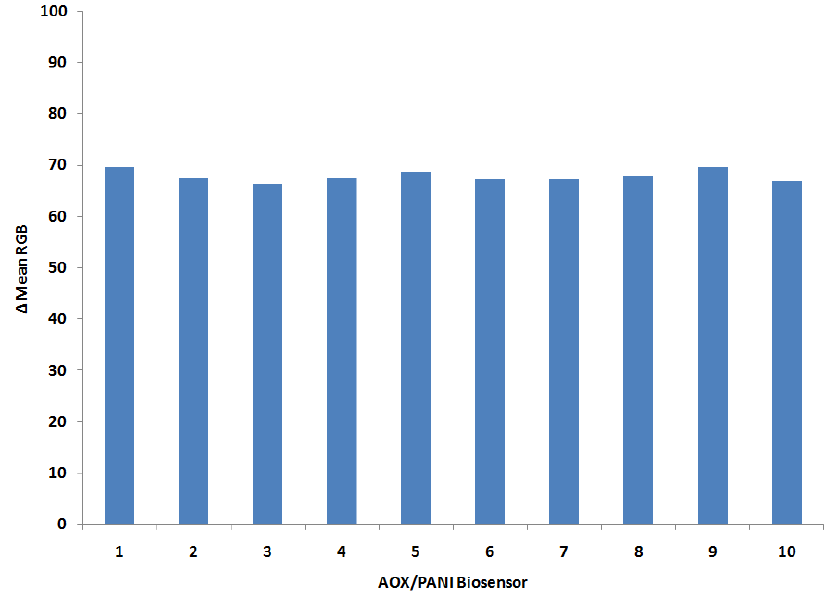
Figure 5. Reproducibility the AOX/PANI biosensor toward ethanol (1%) at pH buffer 7.0.